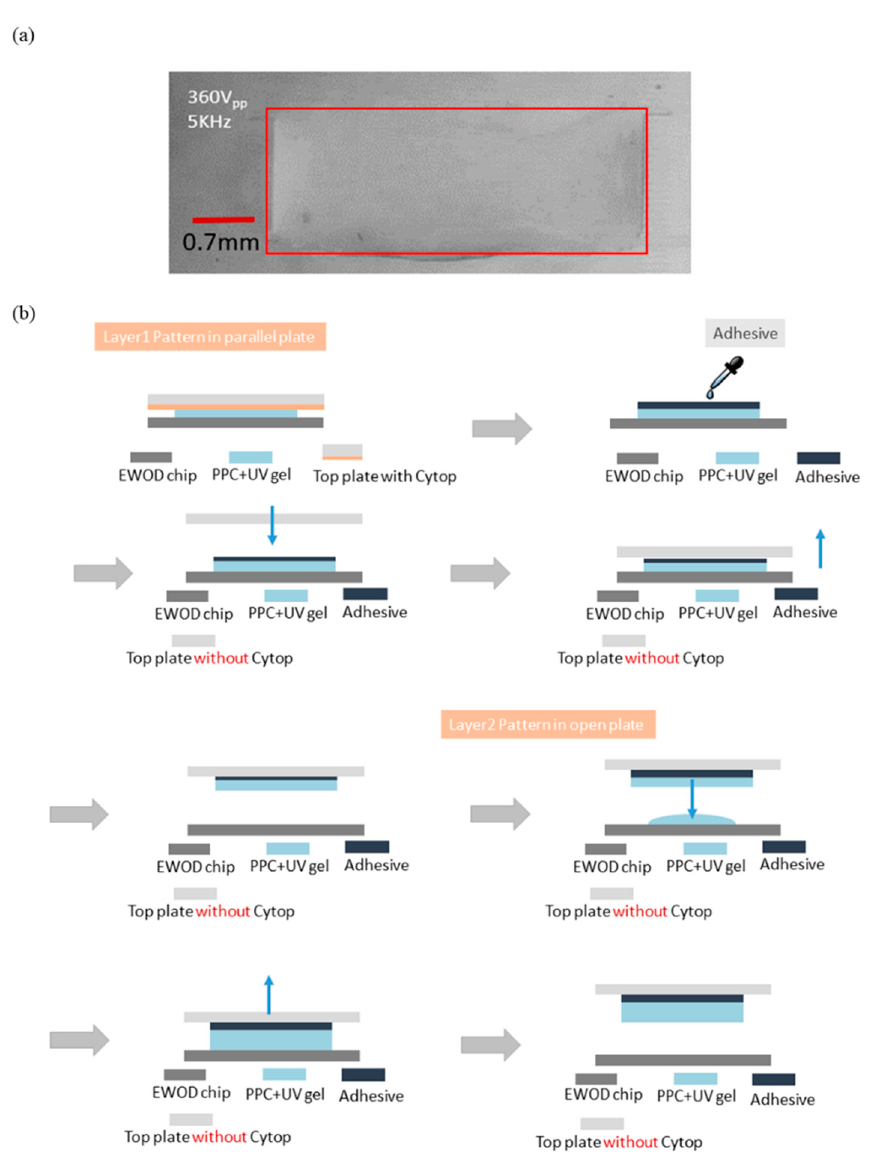
Figure 9. ( a ) 360 Vpp/5 kHz colloid completely covers electrodes in two seconds; ( b ) model stacking process flow by DEP system with UV-SIL liquid.